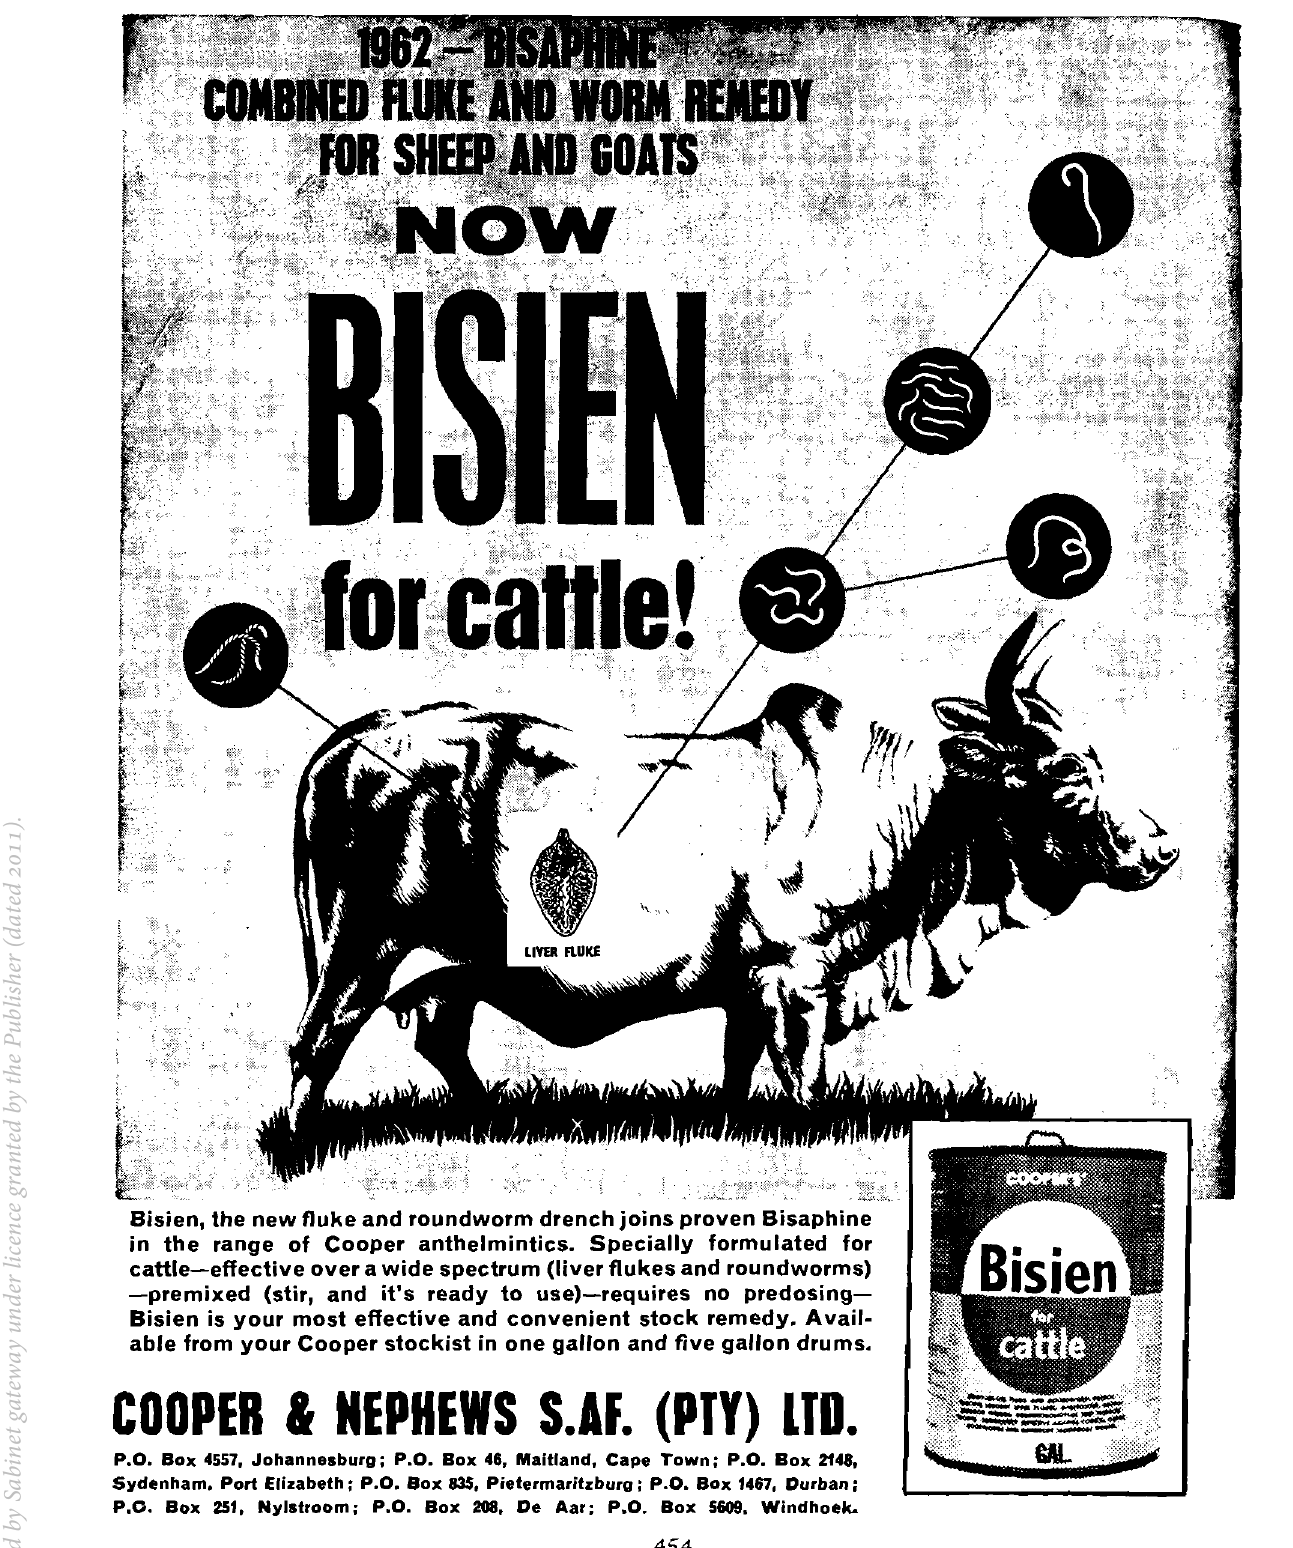
Bisien is your most effective and convenient stock remedy. Avail able from your Cooper stockist in one gallon and five gallon